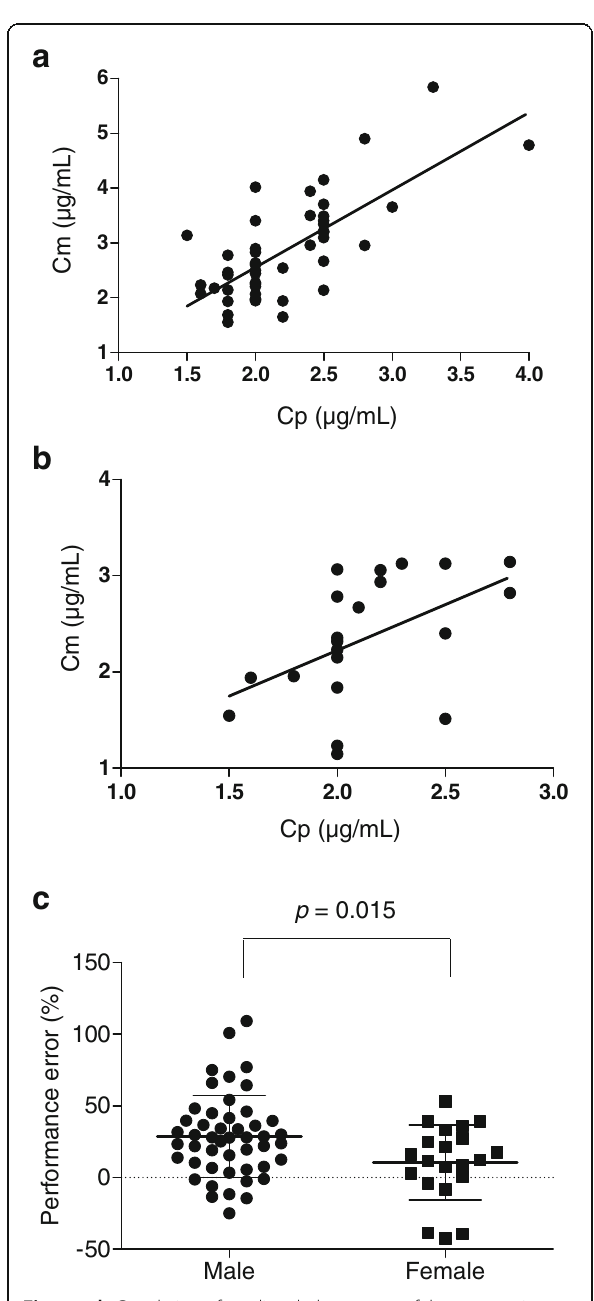
Fig. 1 a , b Correlation of predicted plasma propofol concentration (Cp) and measured plasma propofol concentration (Cm) by sex: a men and b women. c Differences of performance error by